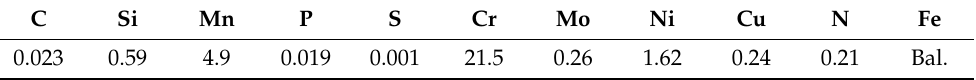
Table 1. Nominal chemical compositions (wt.%) of the S32101 duplex stainless steels.